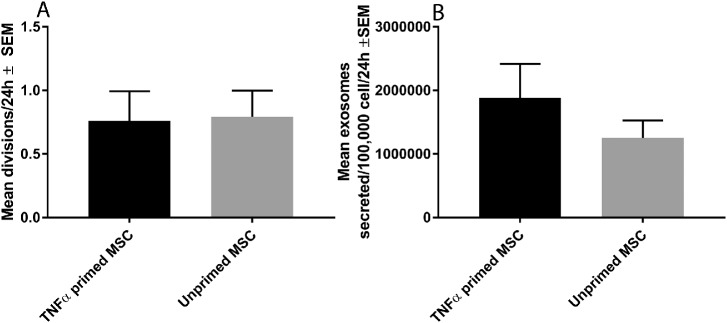
Division and exosome secretion rate of primed MSCs. (A) The mean number of divisions of unprimed MSCs and those primed by TNFα. (B) The mean number of exosomes secreted by unprimed MSCs and those primed by TNFα (n = 3, no significant differences observed at P > 0.05).